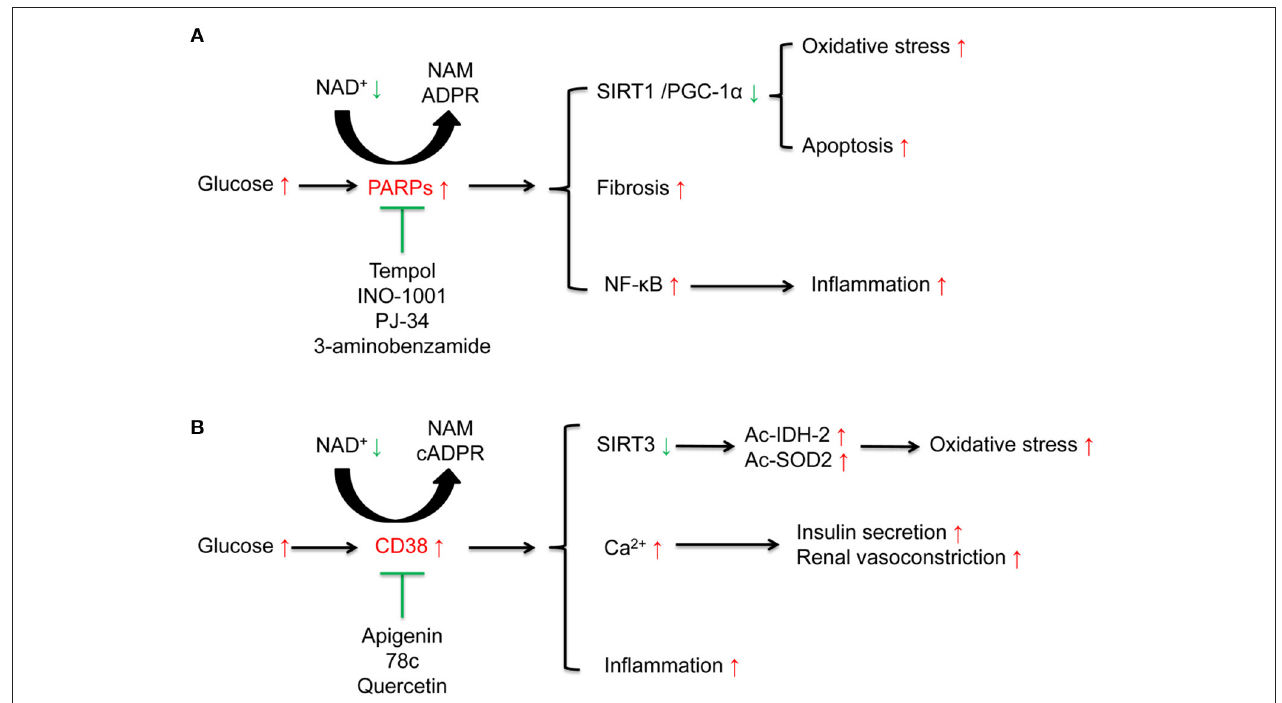
FIGURE 3 | Effects of poly (ADP-ribose) polymerases (PARPs), and the cyclic ADP-ribose (cADPR) synthases CD38 in diabetic kidney disease (DKD). (A) High glucose activates NAD + consuming enzyme PARPs. The activated PARPs can induce oxidative stress and apoptosis by inhibiting the sirtuins 1(SIRT1)/peroxisome proliferator-activated receptor gamma coactivator 1 α (PGC-1 α ) signaling, accelerate renal fibrosis, and enhance inflammation by activating nuclear factor- κ B (NF- κ B). PARP inhibitors such as tempol, INO-1001, PJ-34, 3-aminobenzamide, can ameliorate these alterations induced by high glucose. (B) High glucose activates NAD + consuming enzyme CD38. On one hand, CD38 induces the acetylation of isocitrate dehydrogenase 2 (IDH2) and superoxide dismutase 2 (SOD2) to aggravate oxidative stress via suppression of SIRT3 activity and is closely related to inflammation. On the other hand, CD38 is responsible for insulin secretion and renal vasoconstriction via regulating Ca 2 + release. CD38 inhibitors including apigenin, 78c, and quercetin can suppress these alterations induced by high